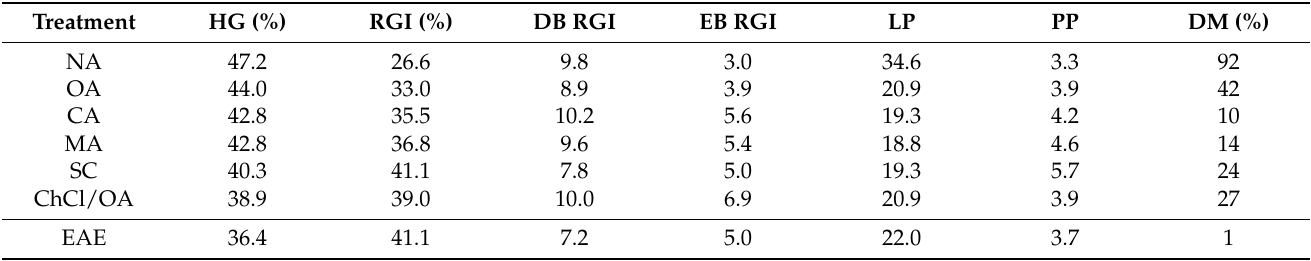
Table 3. Structural parameters inferred from the monomeric composition of pectin from grape pomace treated by (A) NA (Nitric Acid), OA (Oxalic Acid), CA (Citric Acid), MA (Malic Acid), ChCl/OA (DES Choline Chloride/Oxalic Acid), SC (Sodium Citrate), EAE (Enzymatic-Assisted Extraction). HG; Homogalacturonan, RGI; Rhamnogalacturonan-I, DB; Degree of Branching, LP; Linearity Pectin, PP; Pectin Purity, DM; Degree of Methyl